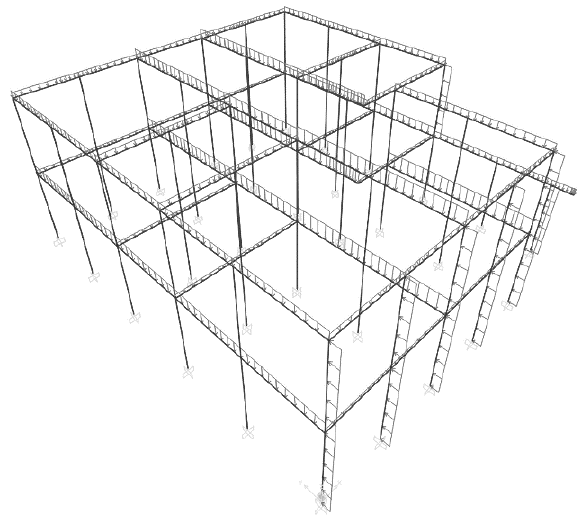
Figure 13. Schematic diagram of the overall structure model under the action of loads.